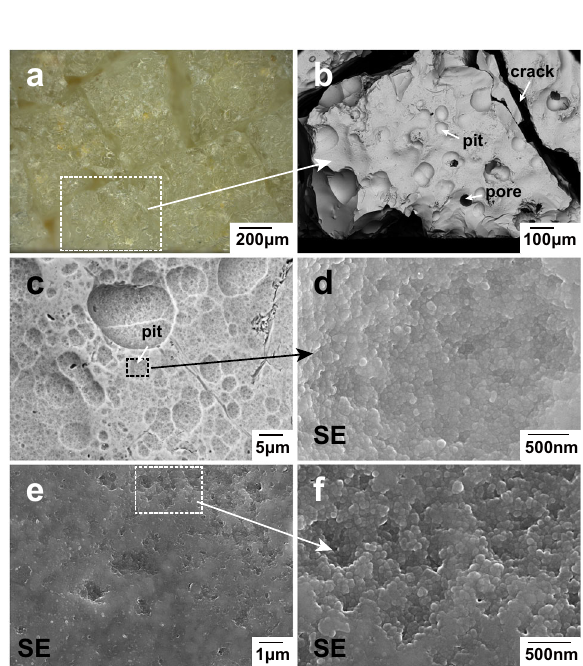
Fig. 2 OM and SEM images of sample No. 06. a and b are the OM and SEM images of the glaze surface, respectively; c SEM image of the hemispherical pits on the glaze surface: the rectangle region in b ; d SEM image of the submicron spherical aggregates on the inner wall of a pit; e SEM image of the irregularly shaped pits on the glaze surface; f SEM image of the submicron spherical aggregates in the irregularly shaped pits; b and c are backscattered electron images, and d – f are secondary electron